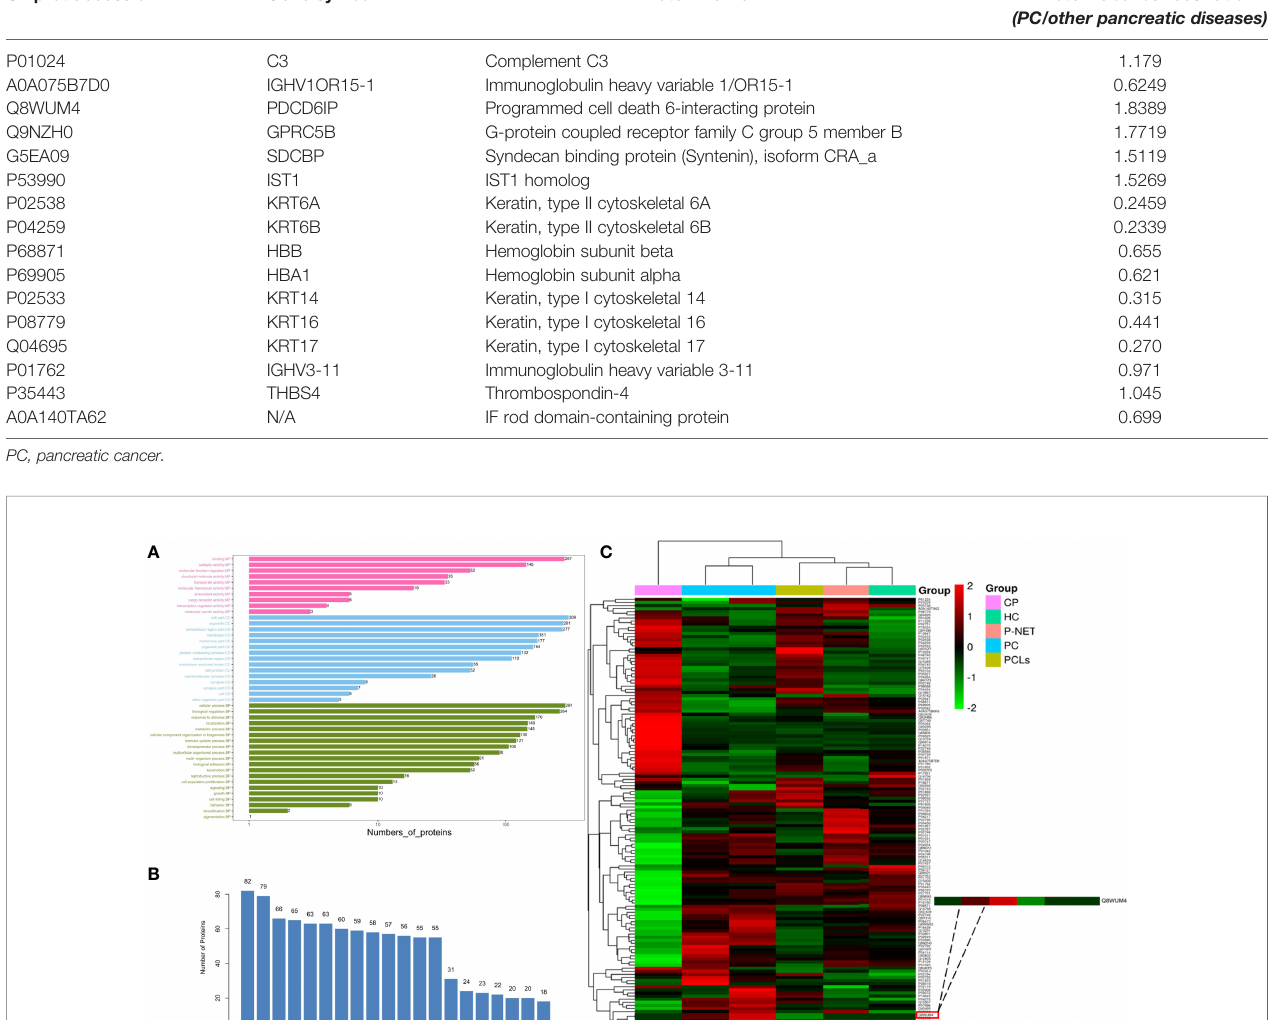
TABLE 1 | An overlap of 16 differentially expressed proteins between the exosomes of PC and other pancreatic diseases. Uniprot accession Gene symbol Protein name Protein abundances ratio